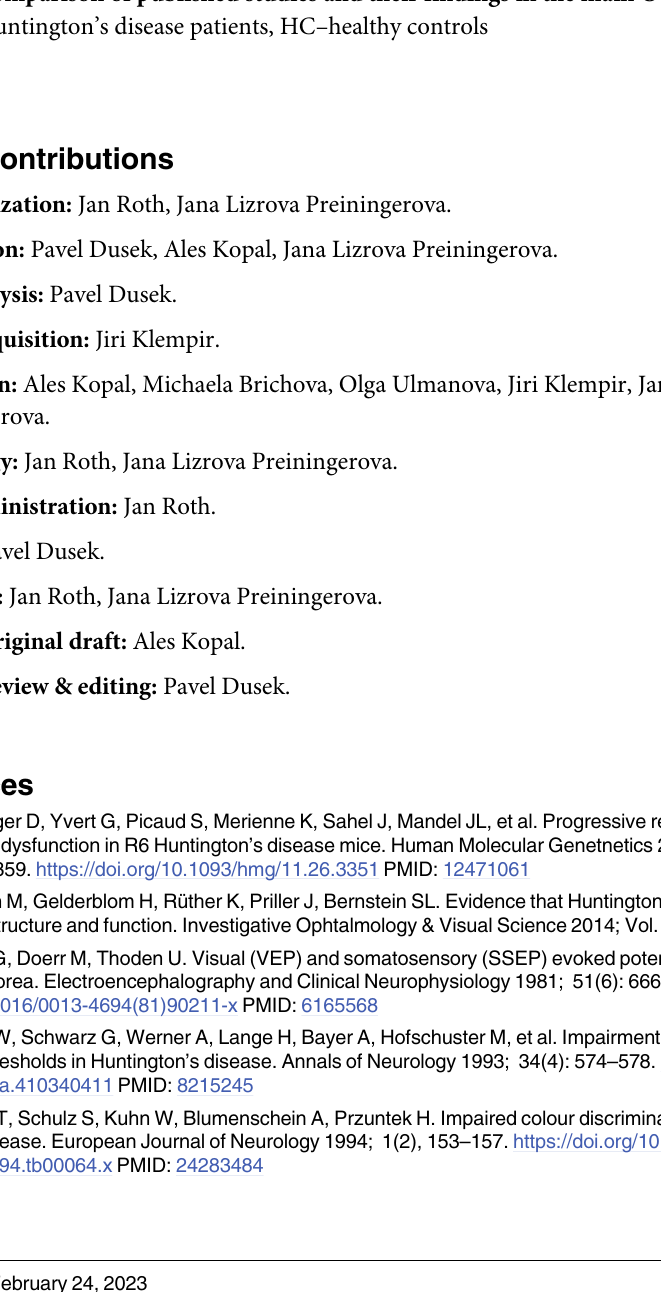
S1 Table. Comparison of published studies and their findings in the main OCT parame- ters. HD–Huntington’s disease patients, HC–healthy